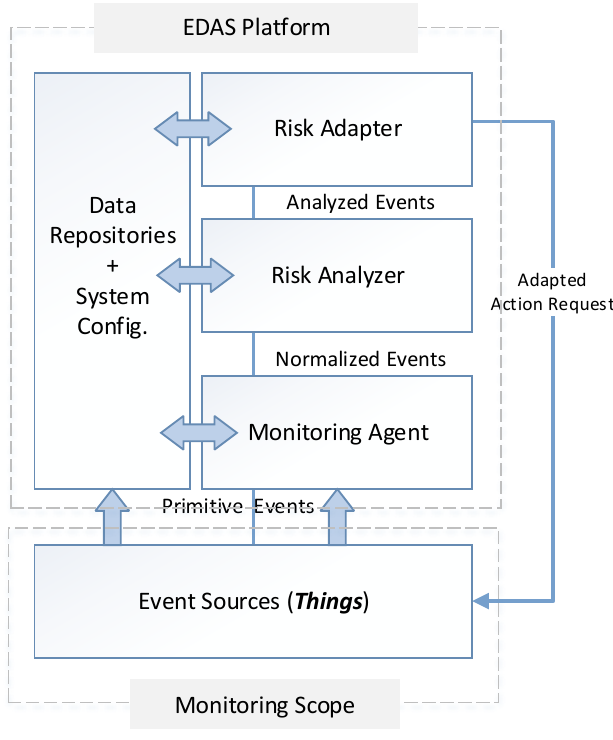
Figure 1. Abstract diagram of event-driven adaptive security architecture (EDAS) architecture.